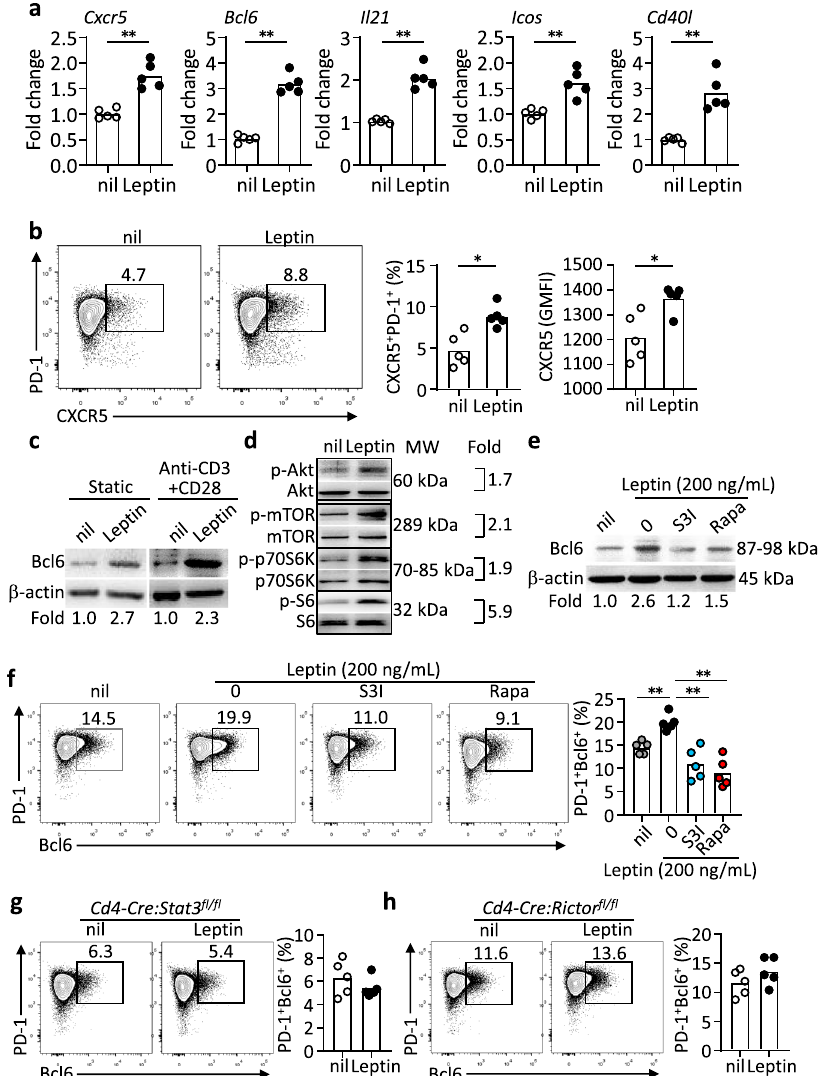
Fig. 6 Stat3 and mTOR are dispensable for leptin-induced T FH differentiation and Bcl6 expression. a Real-time PCR analysis of mouse T FH -related genes in naïve CD4 + T cells from WT mice stimulated with anti-CD3/CD28 for 2 days, further treated with leptin for 12h ( Cxcr5 : ** P = 0.0029, Bcl6 : ** P = 0.0004, Il21 : ** P = 0.0007, Icos : ** P = 0.0028, Cd40l : ** P = 0.0023) ( n = 5). b Representative FACS plots and statistics of CXCR5 + PD-1 + T FH cells in cultured naïve CD4 + T cells from WT mice with anti-CD3/CD28 stimulation for 48h, followed with or without leptin treatment for 12h (Ratio: * P = 0.0200, GMFI: * P = 0.0243). c – e Western blot assay of Bcl6 with or without anti-CD3/CD28 activation ( c ), the phosphorylation of Akt, mTOR, p70S6K and S6 ( d ) and Bcl6 expressions in WT naïve CD4 + T cells with Stat3 inhibition (S3I-201, 100 μ M), mTOR inhibition (Rapamycin, 200nM) plus leptin (200ng/mL) treatment for 12h ( e ). Values showing the fold changes relative to the non-treated control. f Representative FACS plots and statistics of PD-1 + Bcl6 + T FH cells in cultured naïve CD4 + T cells from WT mice with anti-CD3/CD28 activation for 2 days, followed with Stat3 inhibition (S3I-201, 100 μ M), mTOR inhibition (Rapamycin, 200nM) plus leptin (200ng/mL) treatment for 12h (0 vs nil: ** P = 0.0004, S3I vs 0: ** P = 0.0023, Rapa vs 0: ** P = 0.0026) ( n = 5). g , h Representative FACS plots of PD-1 + Bcl6 + T FH cells in cultured naïve CD4 + T cells from Cd4-Cre:Stat3 fl / fl mice ( g ) and Cd4-Cre : Rictor fl / fl mice ( h ) with anti-CD3/CD28 activation for 2 days, followed with or without leptin (200ng/mL) treatment for 12h ( n = 5). Data are shown for individuals (dots) and mean (bars) values, and analysed by Mann – Whitney U-test ( a , b ), or two-way ANOVA ( f ). * P <0.05, ** P <0.01. Results are representative of three independent